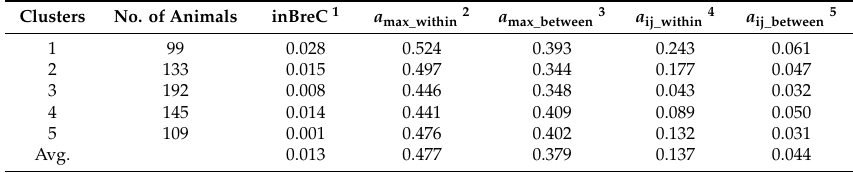
Table 1. Relationship comparisons among Korean Yorkshire pigs within and across clusters. Clusters No. of Animals